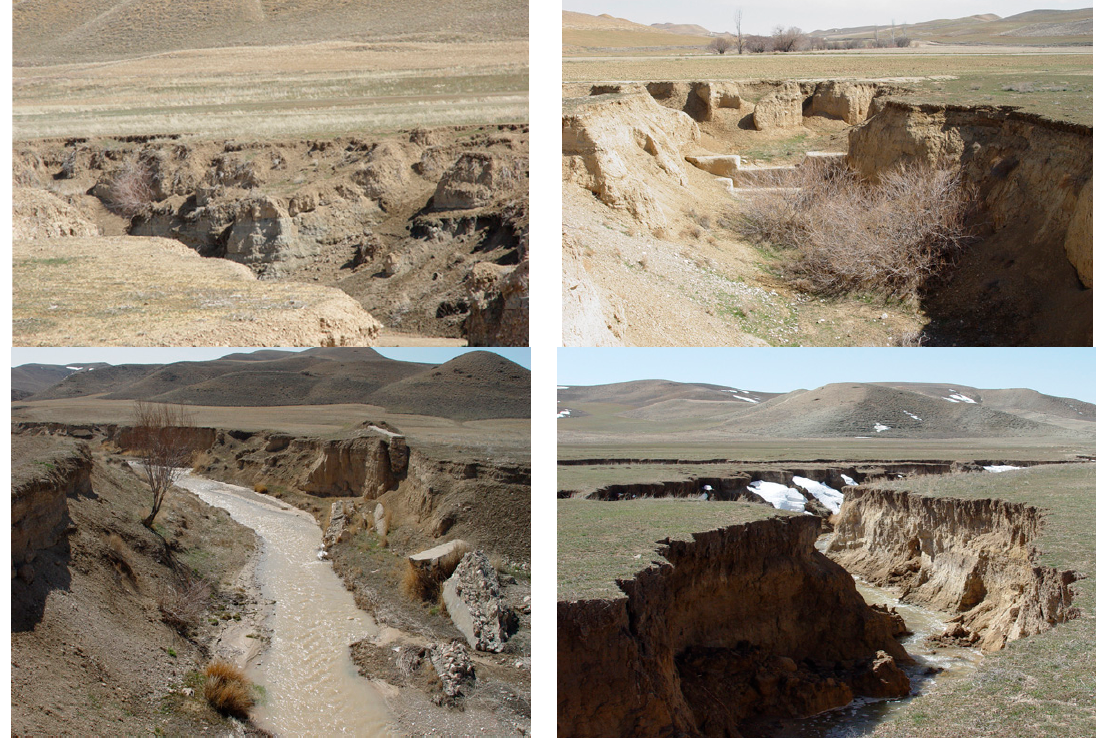
Figure 2. Photos of gully erosion in the Klocheh Watershed, Kurdistan province, Iran.